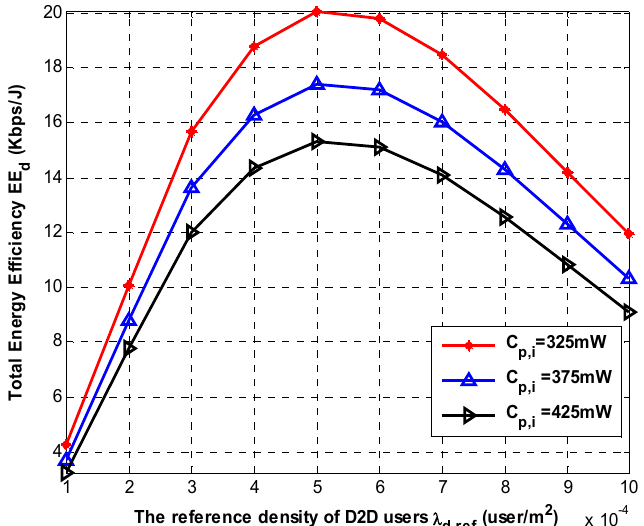
Figure 3. The Energy Efficiency of D2D users with the reference density of D2D users by using the